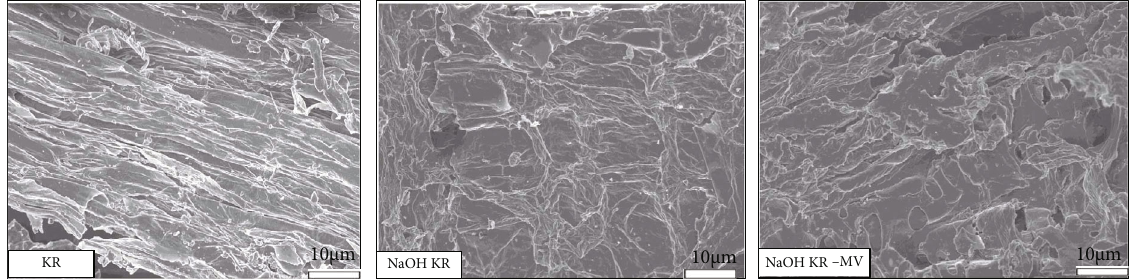
Figure 8: SEM surface morphology of untreated KR, unused NaOH-KR, and NaOH-KR after adsorption of MV, at 1,000x magni fi